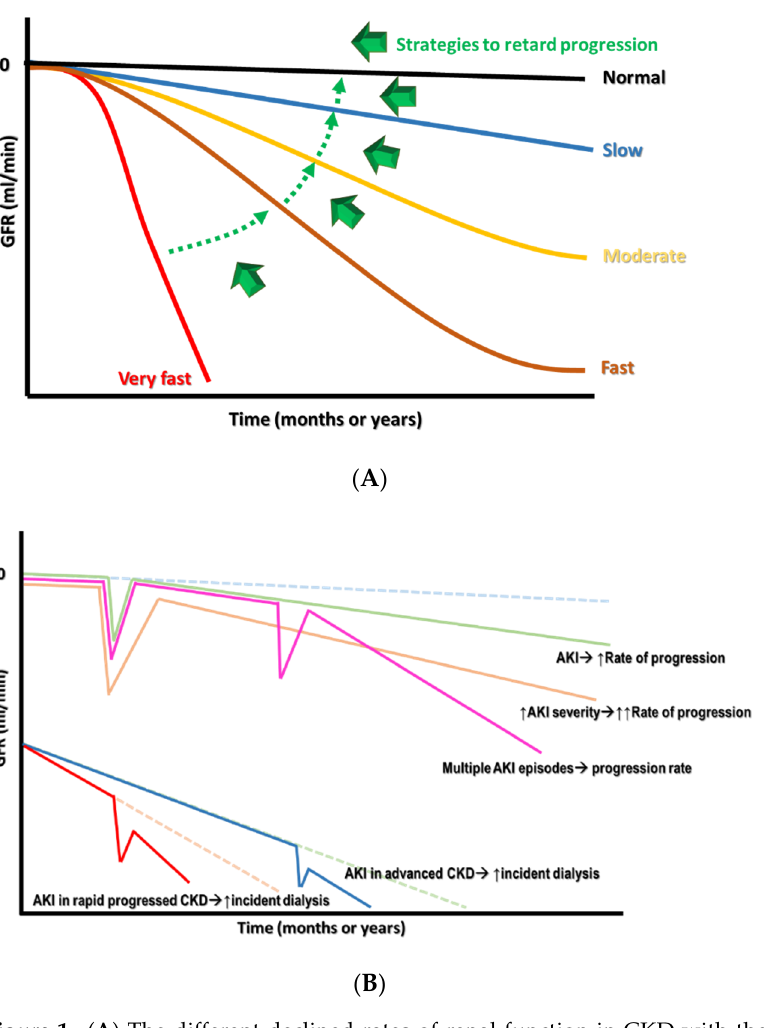
Figure 1. ( A ) The different declined rates of renal function in CKD with the target switch from superfast to slow rate. ( B ) The consequence of AKI on CKD progression, depending on the severity and frequency of episodes.